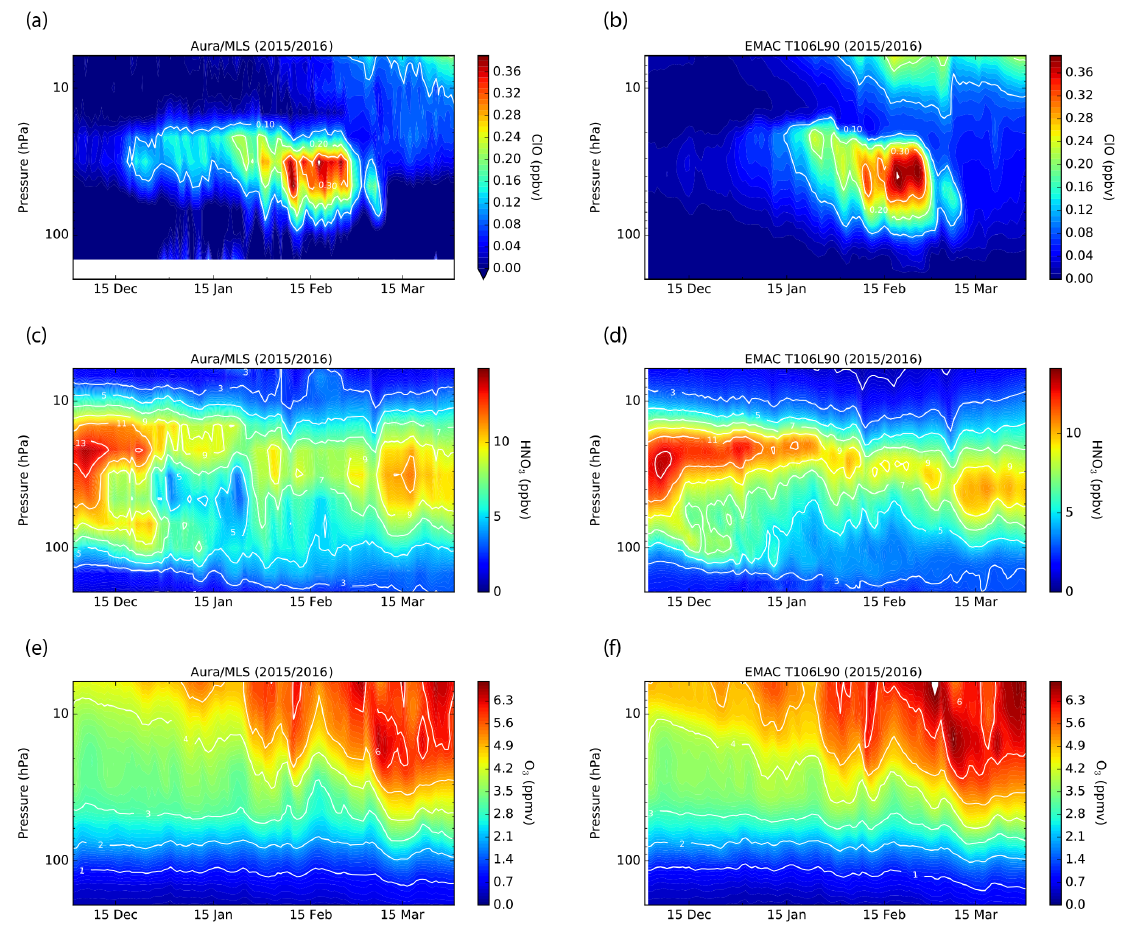
Figure 13. Temporal evolution of daily mean ClO, HNO 3 and O 3 at northern high latitudes (averaged over 70–90 ◦ N) as a function of pressure as observed by Aura/MLS (a, c, e) and simulated by EMAC T106L90 (b, d, f) for the 2015/2016 Arctic winter (EMAC SORBIT output